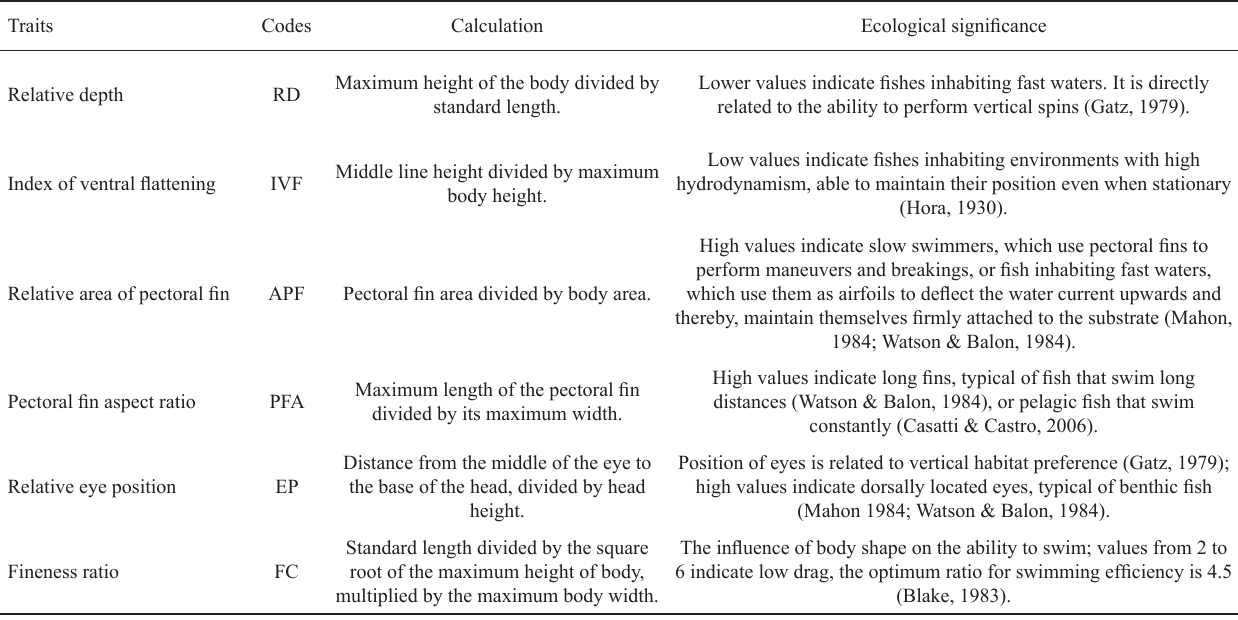
Table 2 . Codes, calculations and ecological significance of ecomorphological traits related to habitat use. For details of how measurements were taken see Cochran-Biederman & Winemiller (2010). All measurements were taken in millimeters